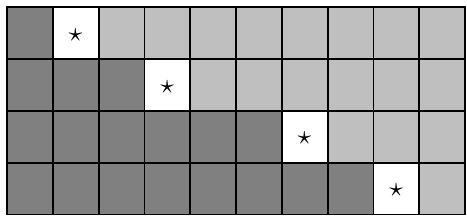
Figure 12. Table encoding the function S